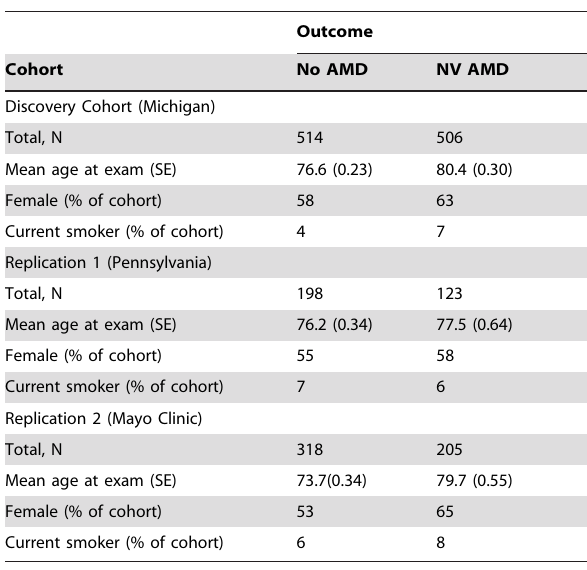
Table 1. Description of Cohorts.